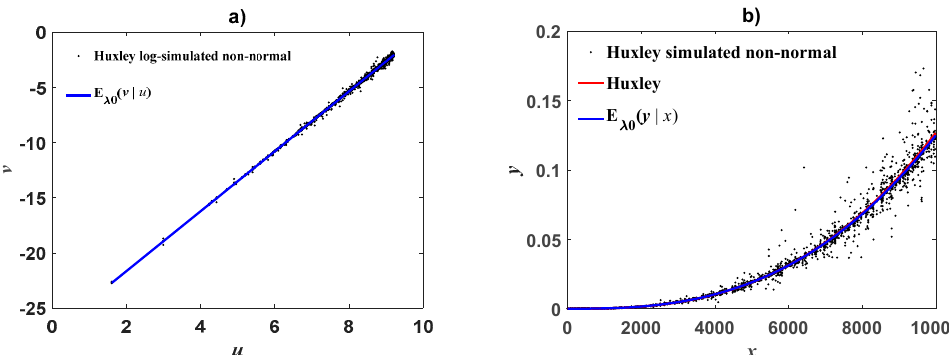
Figure A4. TAMA fit on simulated non-lognormally distributed replicates. Panel ( a ) displays spread of 𝑣 (cid:3038)((cid:3036)) (𝜖) replicates about the mean response line 𝜆 (cid:2868) (𝑢) = 𝑝 (cid:2868) + 𝑞 (cid:2868) 𝑢 . Panel ( b ) comparison of mean response 𝐸 (cid:3090)(cid:2868) (𝑦|𝑥) and power function 𝑦 (cid:3036) = 𝛽(cid:4632)𝑥 (cid:3036)(cid:3080)(cid:3549) fitted in direct arithmetical space by means of non-